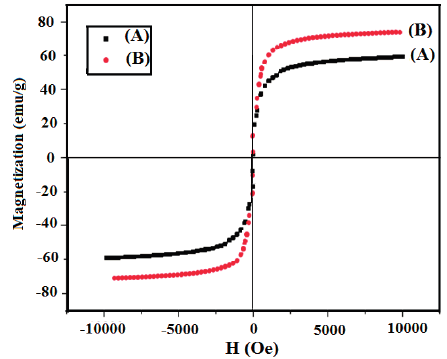
Figure 10. VSM magnetization curves of magnetite coated with (A) R-AN and (B) RK-AN amidoximes. Table 2. Efficiency of magnetite nanoparticles at different MOR with Arabian heavy crude oil. Magnetite MOR Efficiency Index (%EI) Uncoated